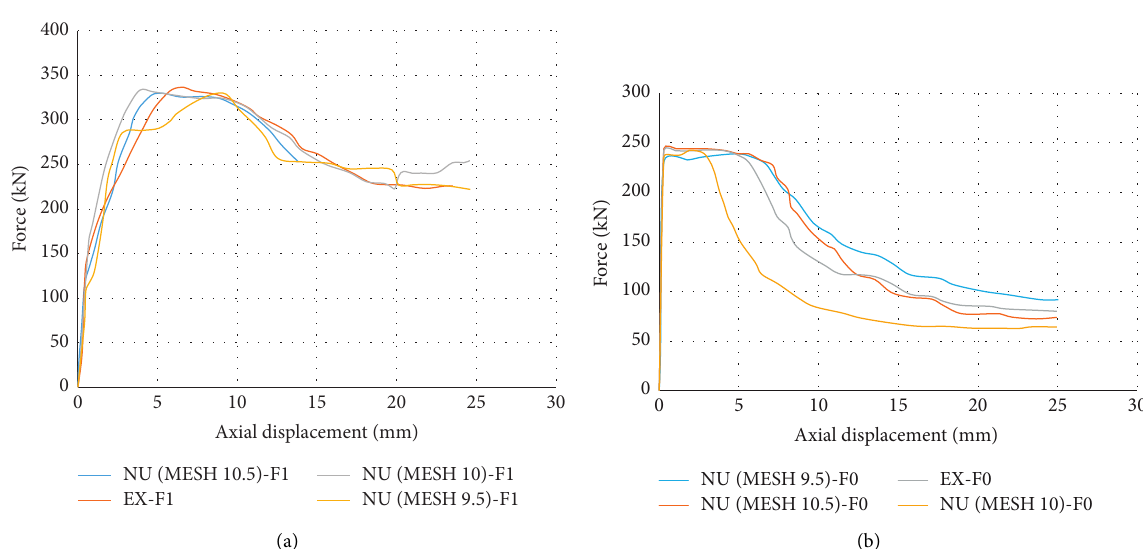
Figure 2: Validation results of modeling. (a) Retrofitting sample. (b) Nonretrofitting sample [17].